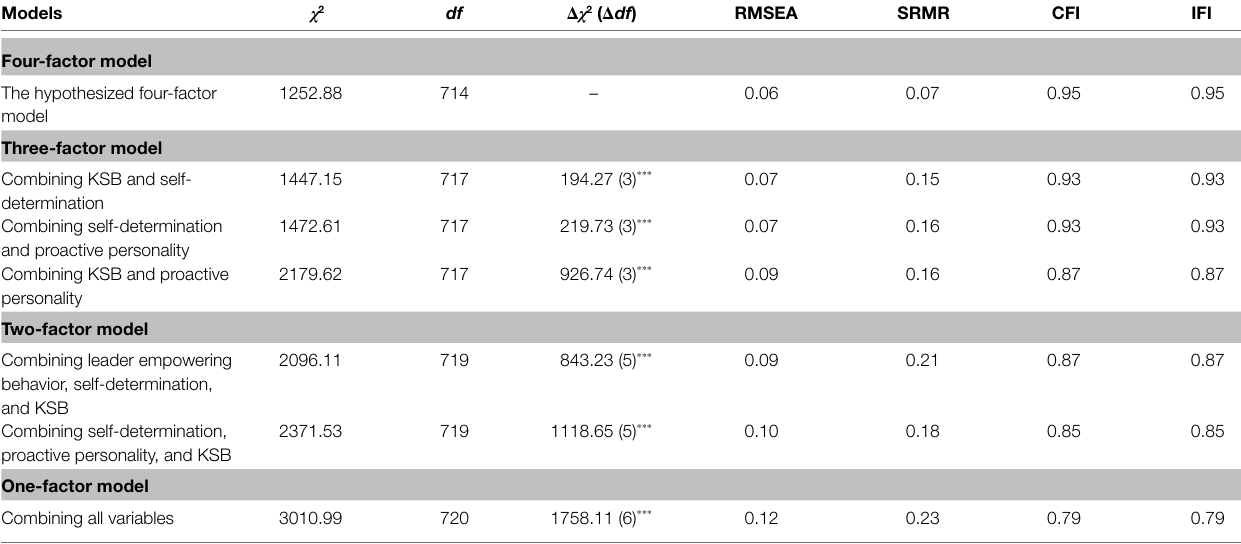
TABLE 1 | Confirmatory factor analysis model fit